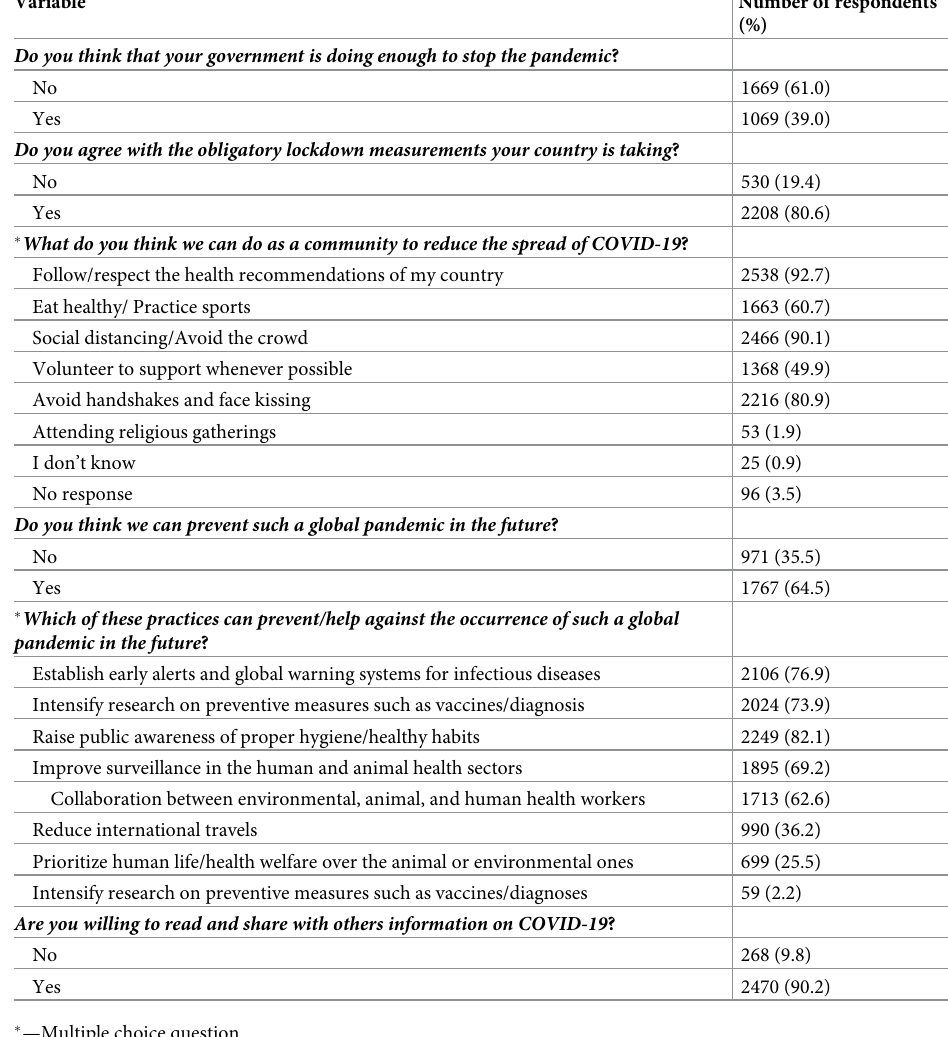
Table 7. Descriptive statistics of respondents’ perceptions of community and global responses associated with the prevention of the pandemic. Variable Number of respondents